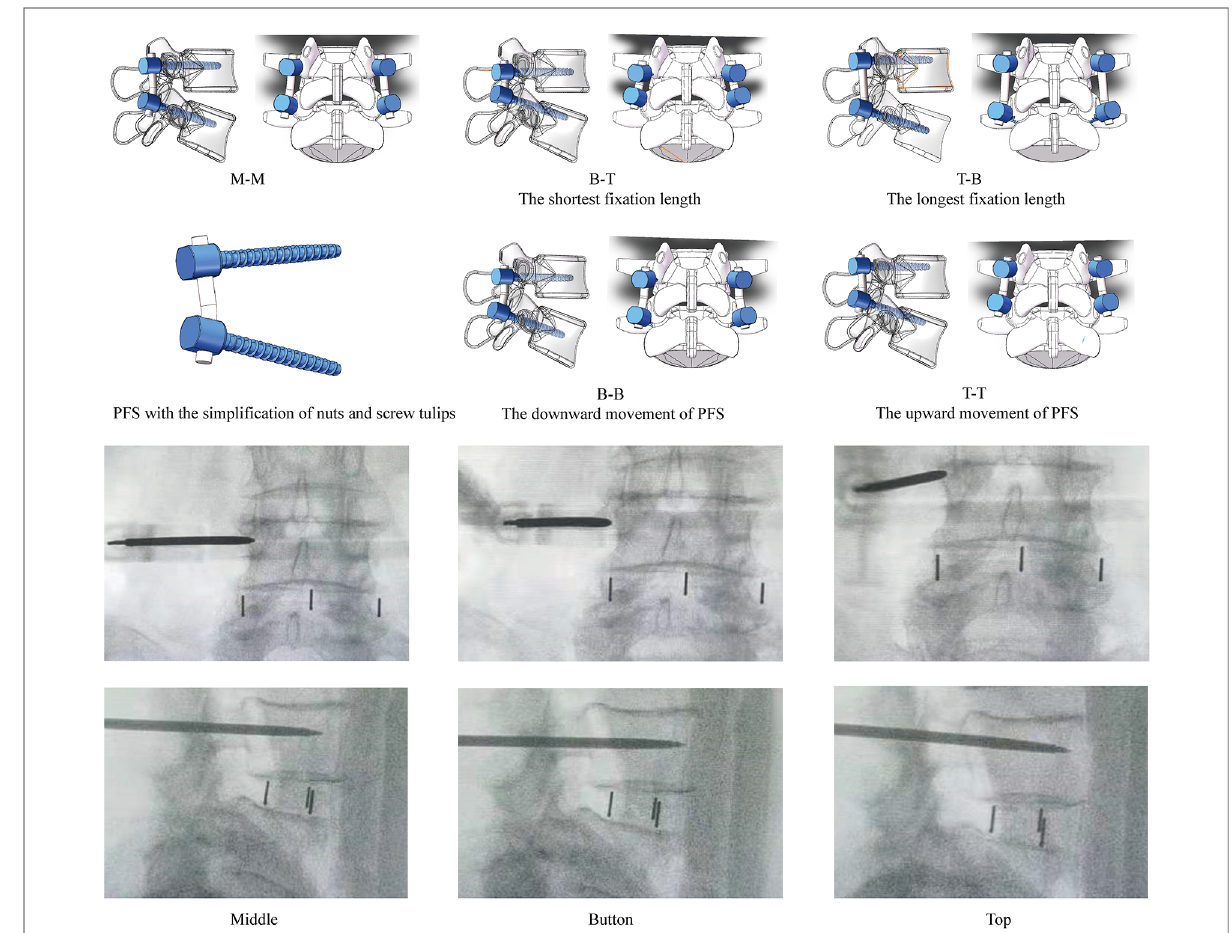
FIGURE 6 Diagrams of OLIF fi xed by PFS with different insertional screw positions, and the highly adjustable of percutaneous BPS insertion. M-M: Screws were inserted into the middle positions of both cranial and caudal vertebral bodies; B-T: Screws were inserted into the bottom of the cranial and the top of the caudal vertebral bodies (Shortest fi xation length of PFS); T-B: Screws were inserted into the top of the cranial and the bottom of the caudal vertebral bodies (Longest fi xation length of PFS); BB: Screws were inserted into the bottom of both cranial and caudal vertebral bodies (The downward movement of PFS); TT: Screws were inserted into the top of both cranial and caudal vertebral bodies (The upward movement of